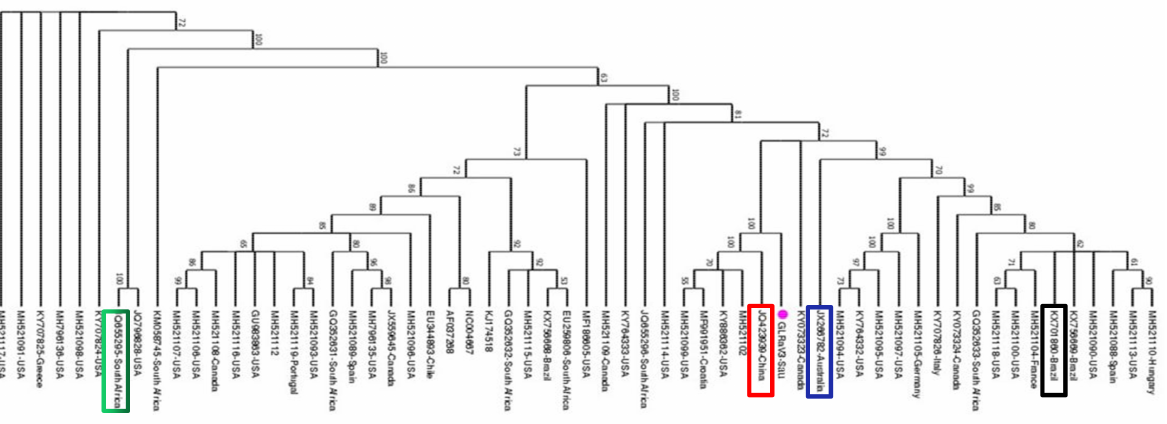
Figure 2. Unrooted phylogenetic tree derived from the nucleotide sequences of grapevine leafroll- associated virus 3 from grape (GLRaV3-Sau, pink dot) and other available isolates in GenBank. The phylogenetic tree was constructed by the neighbor-joining (NJ) method with 500 bootstrap replicates, and bootstrap support is indicated at branch points. The scale bar represents the number of nucleotide replacements per site. The black, purple, red, and green boxes indicate ‘ISAB-BR’, ‘139’, ‘LN‘, ‘GH-11’,